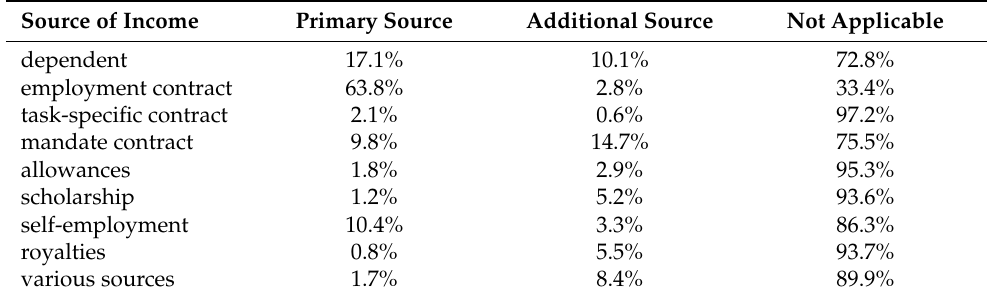
Table 3. Summary of respondents’ sources of income, categorized into primary and secondary